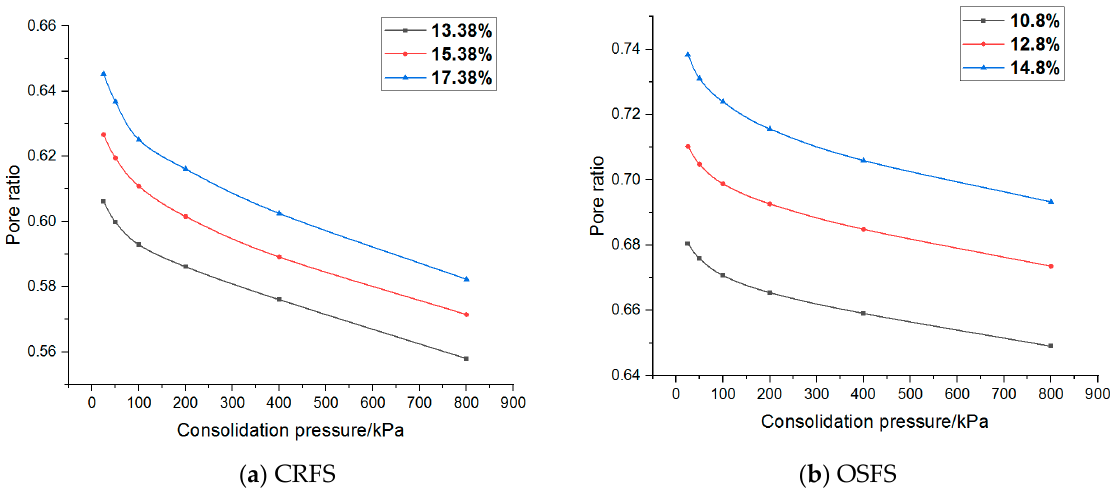
Figure 10. Pore ratio–stress curve of modified soil with different water contents.